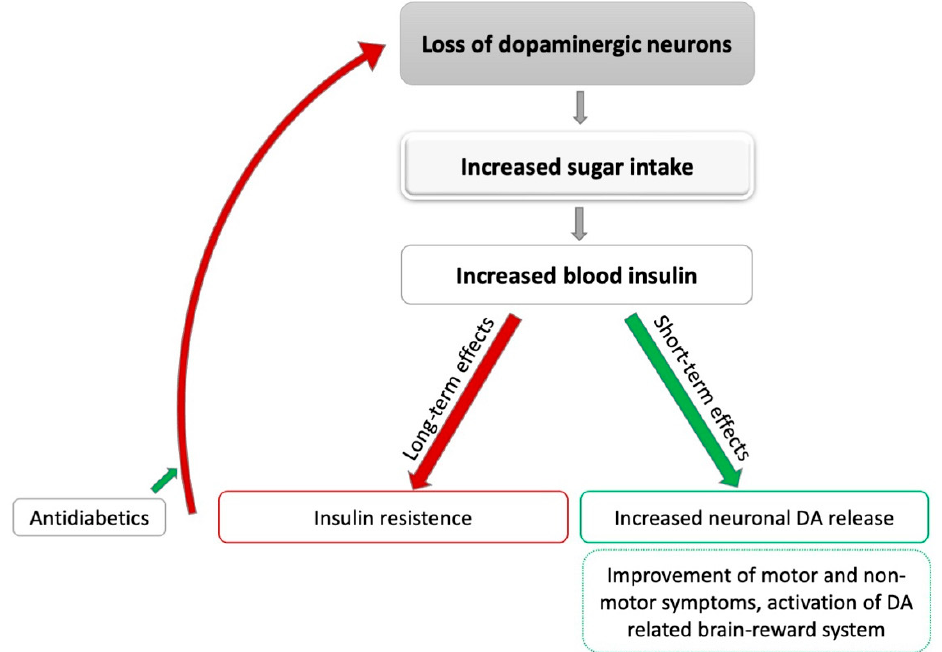
Figure 1 . Potential effects of sugar intake on Parkinson’s disease . DA: dopamine; grey: leads to; Figure 1. Potential effects of sugar intake on Parkinson’s disease. DA: dopamine; grey: leads to; green: positive influence; red: negative influence. green: positive influence; red: negative